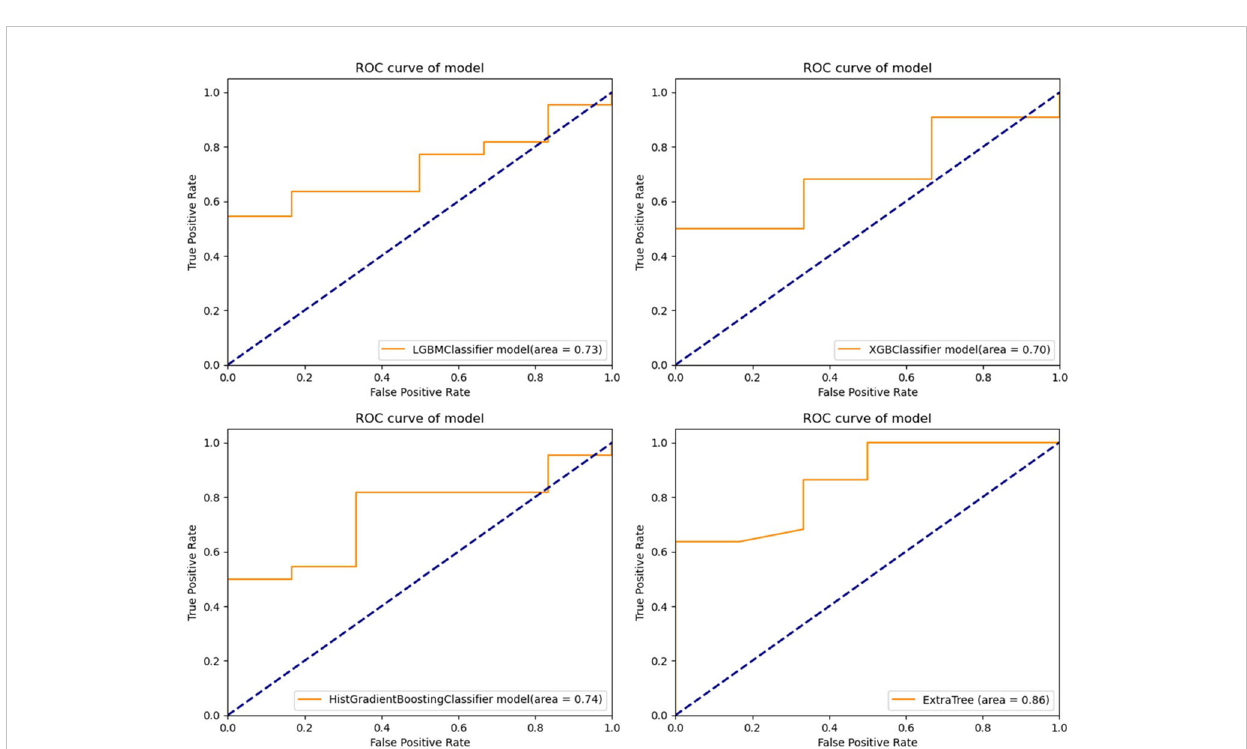
FIGURE 2 Receiver operating characteristic curves of different prediction models for progression free survival in patients with epithelial ovarian cancer (upper left: LGBM model; upper right: XGBoost model; lower left: HGBoost model; lower right: Extra-Trees